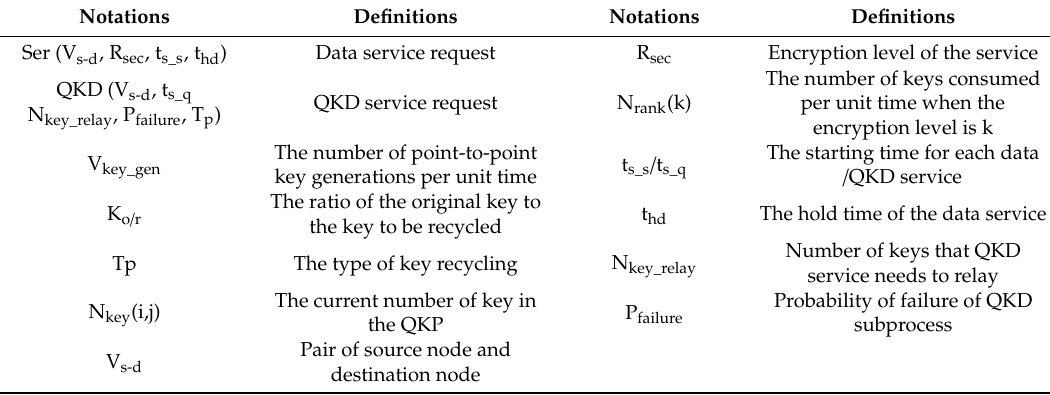
Table 1. Notations and